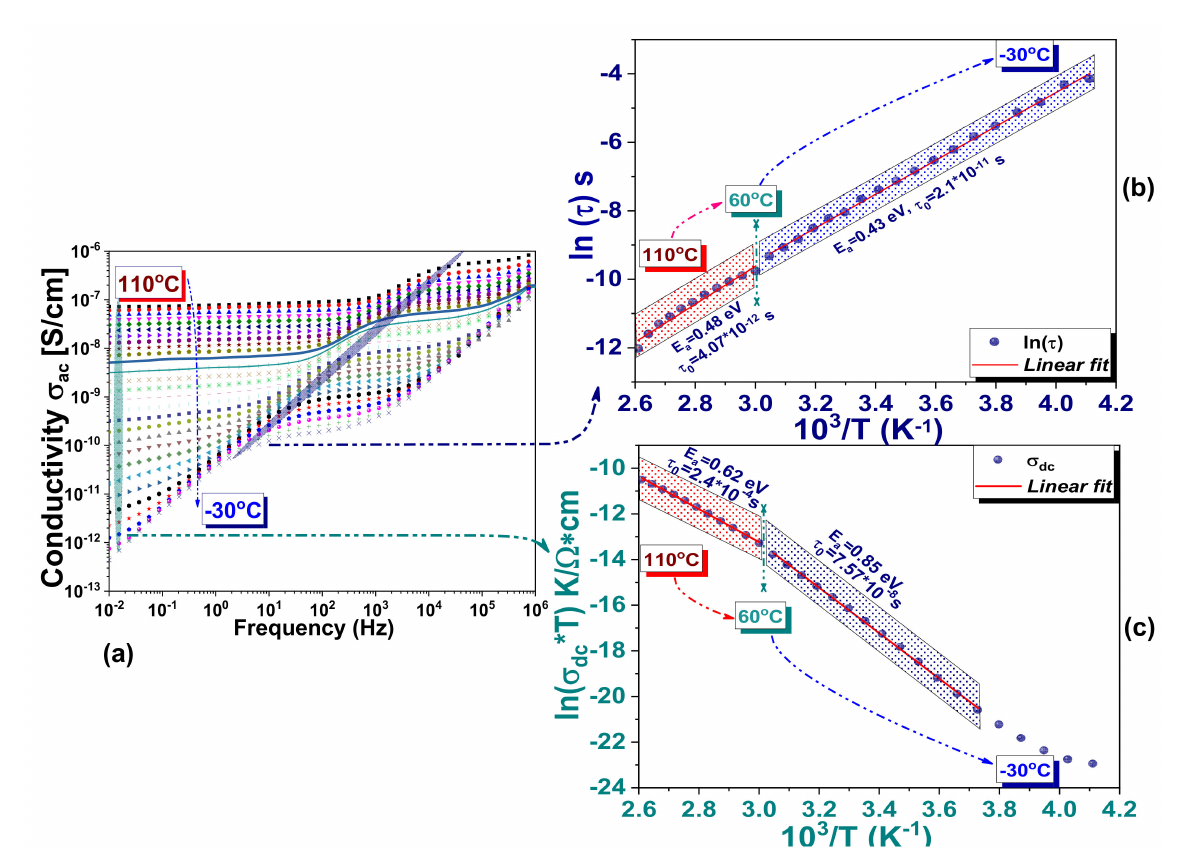
Figure 12. ( a ) Variation of ac conductivity as a function of frequency σ ac ( ν ) measured between − 30 ◦ C and 110 ◦ C; ( b ) linear extrapolation following the relaxation in frequency dependence of the a.c. conductivity in the 10 0 Hz ÷ 10 4 Hz range; ( c ) Arrhenius plots for d.c. conductivity in the low-frequency